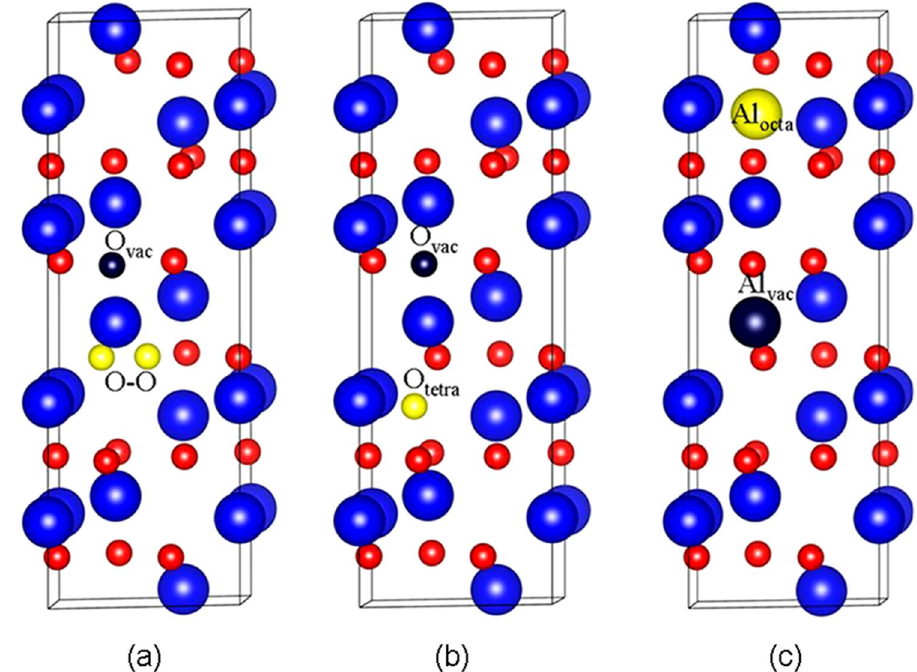
Figure 3. Illustration of schematic view of ( a ) O vac + O-O dumbbell; ( b ) O vac + O tetra and ( c ) Al vac + Al octa . The large blue and small red spheres represent the aluminum and oxygen atoms, respectively. The magenta large and small spheres represent the aluminum vacancy and oxygen vacancy, respectively. The yellow large and small spheres represent the aluminum interstitial and oxygen interstitial, respectively. O-O: oxygen dumbbell pair; O tetra : oxygen interstitial occupying the tetrahedral site; Al octa : aluminum interstitial occupying the octahedral